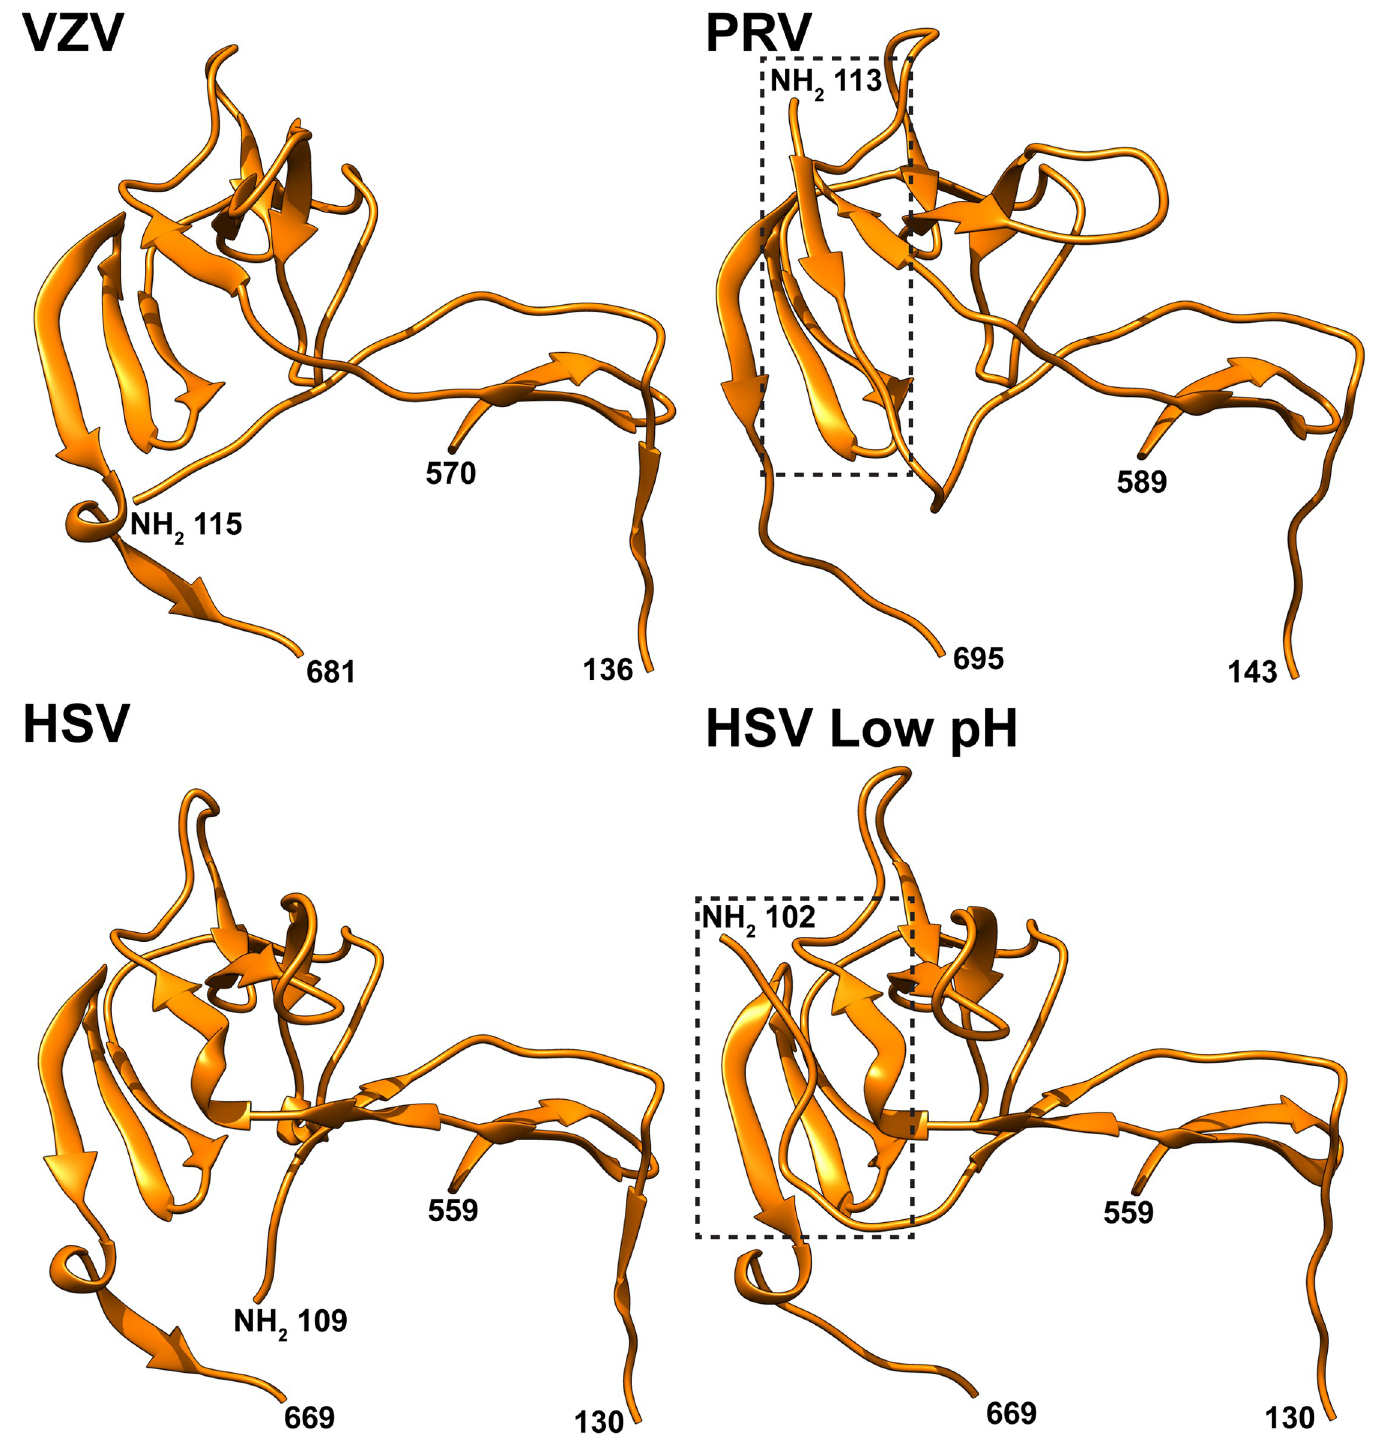
Fig 8. The N-termini of PRV and low pH HSV gB have an ordered structured compared to those of VZV and neutral pH HSV. The gB DIV structures for VZV (PDB), PRV (6ESC[34]), HSV (2GUM[5]) and low pH HSV (3NWF[87]) gB are represented in ribbon format. Residues in the gB structure for the polypeptide chain are indicated. The ordered N-terminal regions of PRV and low pH HSV gB are highlighted by the dotted boxes.